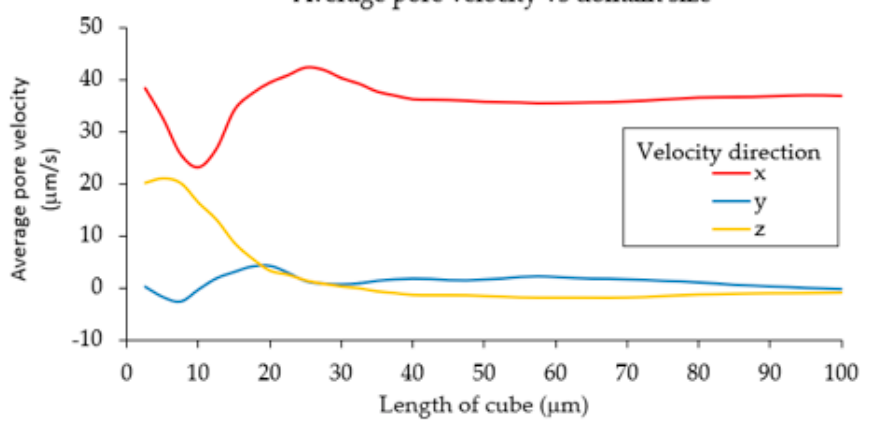
Figure 2. Pore velocity calculated by averaging over an increasing part of the domain volume. The average pore velocity changed with the domain size when water at room temperature flows through the RPS-packed bed in x direction.